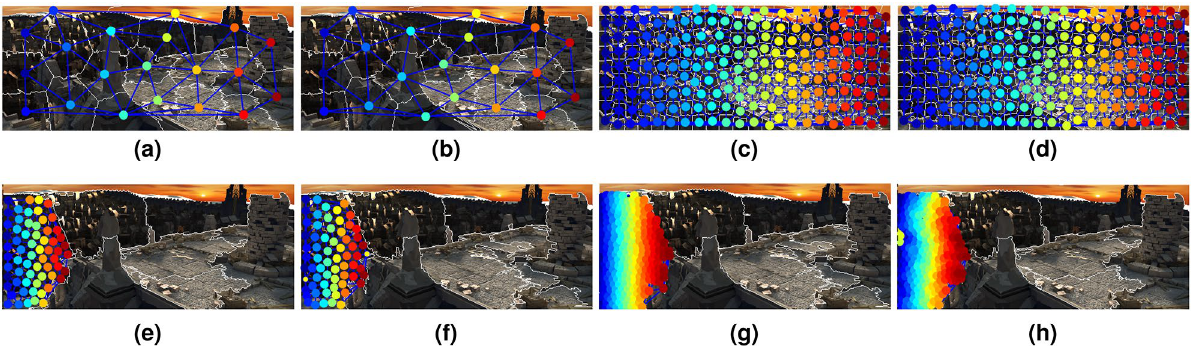
Figure 5. Superpixel size. Graph-matching using different superpixel sizes. The images correspond to the examples of superpixel sizes | s | = 22, 323 (20 superpixels, Figures ( a,b ), | s | = 2232 (200 superpixels, Figures ( c,d ), | s | = 1116 (5 clusters subdivided into 80 superpixels, Figures ( e,f ) and | s | = 223 (5 clusters subdivided into 400 superpixels,Figures ( g,h )respectively. The figures show the colour-coded graph node matches using only graph matching as explained in “Graph matching” section.